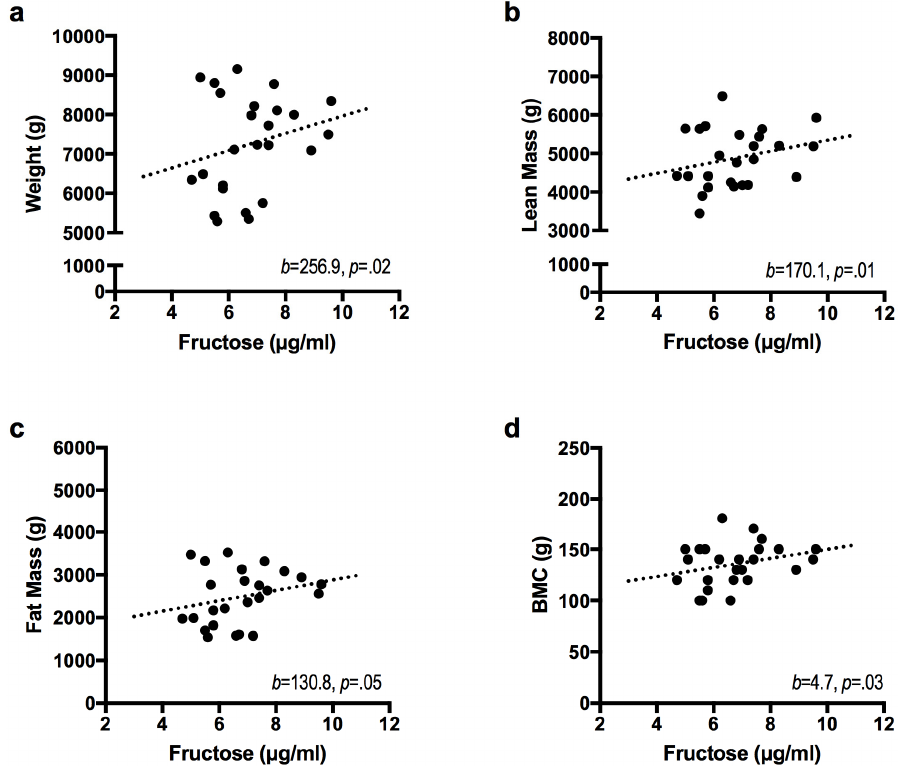
Figure 2. Breast milk fructose is positively associated with infant body composition at 6 months of age. Figures display the unadjusted values for breast milk fructose relative to ( a ) body weight; ( b ) ( c ) fat mass; and ( d ) bone mineral content. Hierarchical linear regression was performed to obtain the lean mass; ( c ) fat mass; and ( d ) bone mineral content . Hierarchical linear regression was performed parameter estimates ( b ) after adjusting for infant sex, one-month infant weight, and maternal body to obtain the parameter estimates ( b ) after adjusting for infant sex, one ‐ month infant weight, and mass index ( n = maternal body mass index ( n = 25).